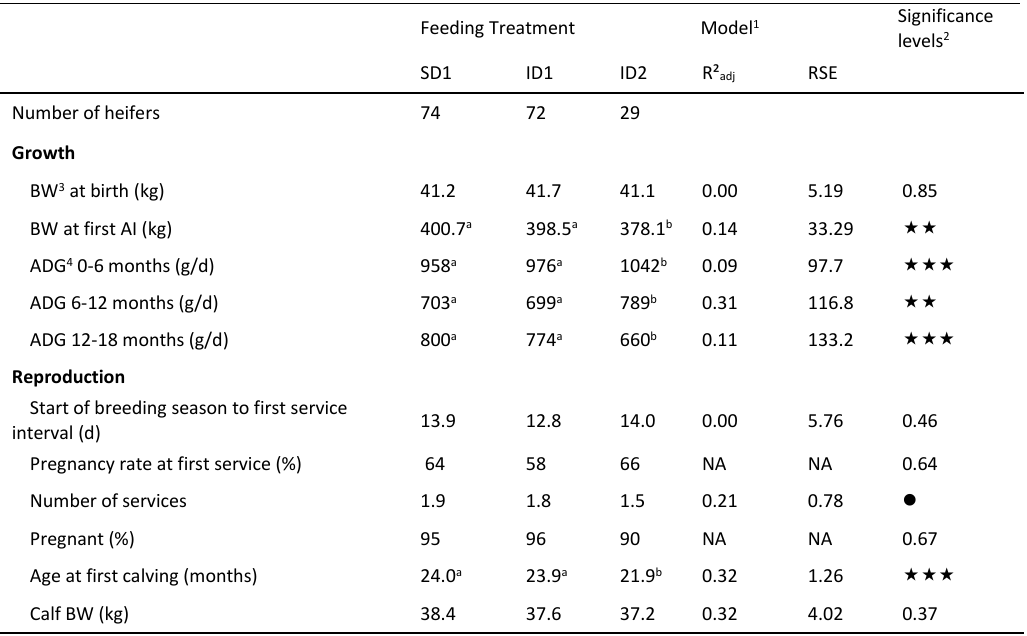
the rearing period Feeding Treatment Model 1